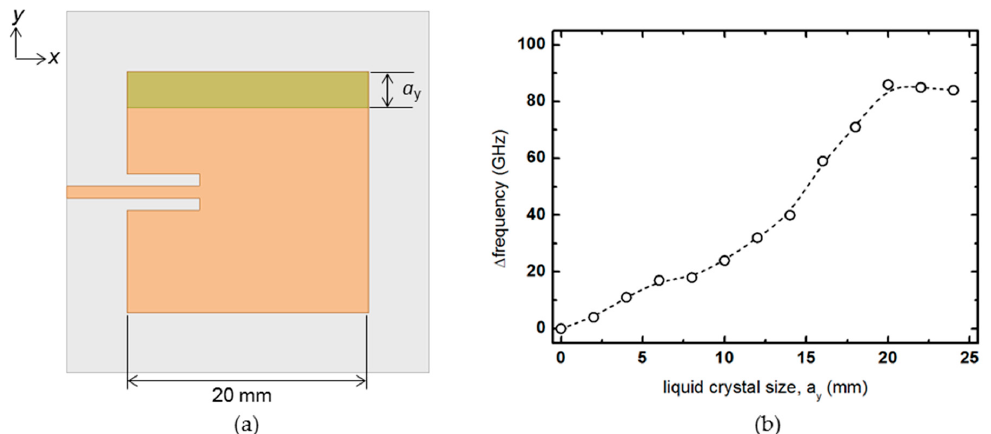
Figure 5. ( a ) Schematic diagram of the patch antenna that increases the size of the liquid crystal in the y -axis, and ( b ) the amount of frequency change.